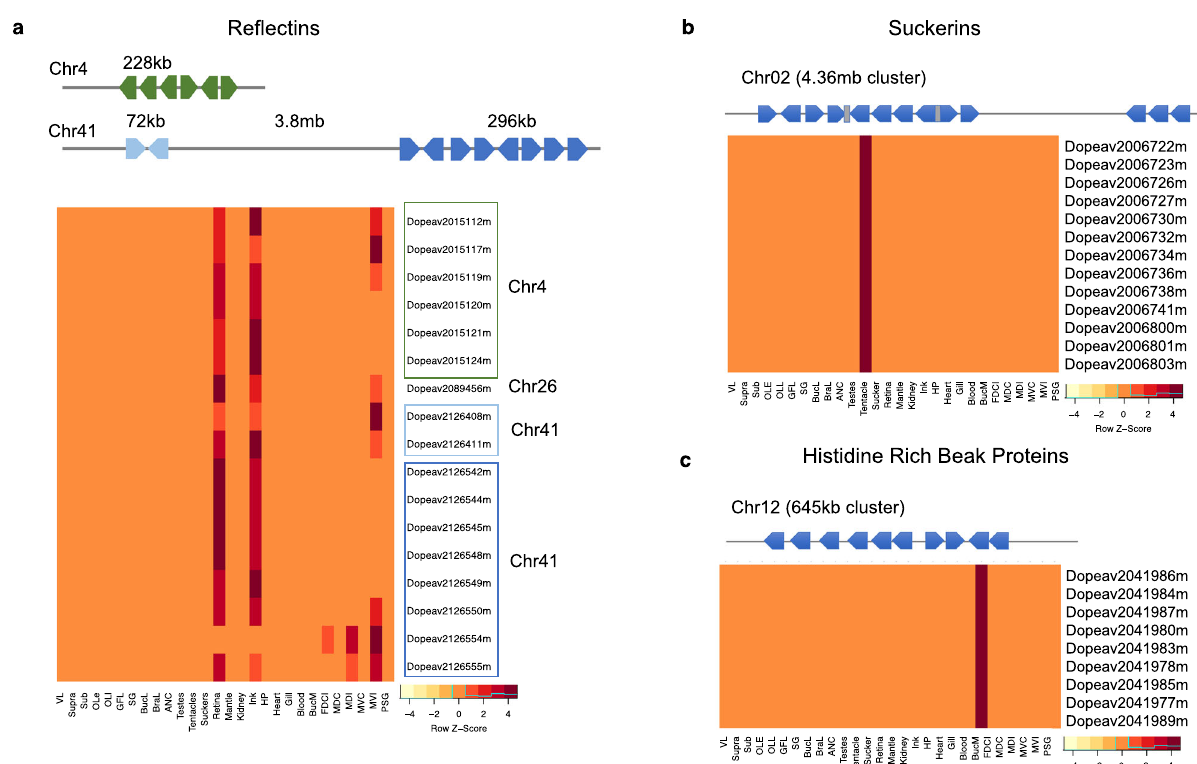
Fig. 8 Cephalopod-speci fi c gene families in the D. pealeii genome. a Re fl ectins in the D. pealeii genome. Top: three clusters of re fl ectins were identi fi ed on two chromosomes, with a single re fl ectin found on chromosome 26 (not shown). Bottom: Re fl ectin expression pro fi les across D. pealeii transcriptomes indicate these genes are deployed in iridescent tissues, including the iridophore layer of the skin, the tissue surrounding the eye (retina), and the ink sac. Cells are colored according to standard deviation from mean expression levels. b Suckerin genes in D. pealeii . Top: the D. pealeii genome contains 13 suckerin genes distributed in two clusters on chromosome 2. Bottom: heatmap of the expression pro fi les of the suckerins across D. pealeii transcriptomes demonstrate that the suckerins are most highly expressed in the club of the tentacle. c Histidine-rich beak proteins in D. pealeii . Top: Cluster of 10 histidine-rich beak proteins on chromosome 12. Bottom: Heatmap of expression pro fi les of histidine-rich beak proteins in D. pealeii transcriptomes demonstrate high expression in the buccal mass. Abbreviations as in Fig. 1 except: BucL buccal lobe, BraL brachial lobe, BucM buccal mass, FDCI dorsal fi n Chromosome-scale assembly of the Euprymna scolopes genome . The E. scolopes assembly was generated using HiC data and assembled with Lachesis 72,73 . Scaffolds of 50kb and longer from the publicly available 27 assembly were used together with aligned Hi-C reads.